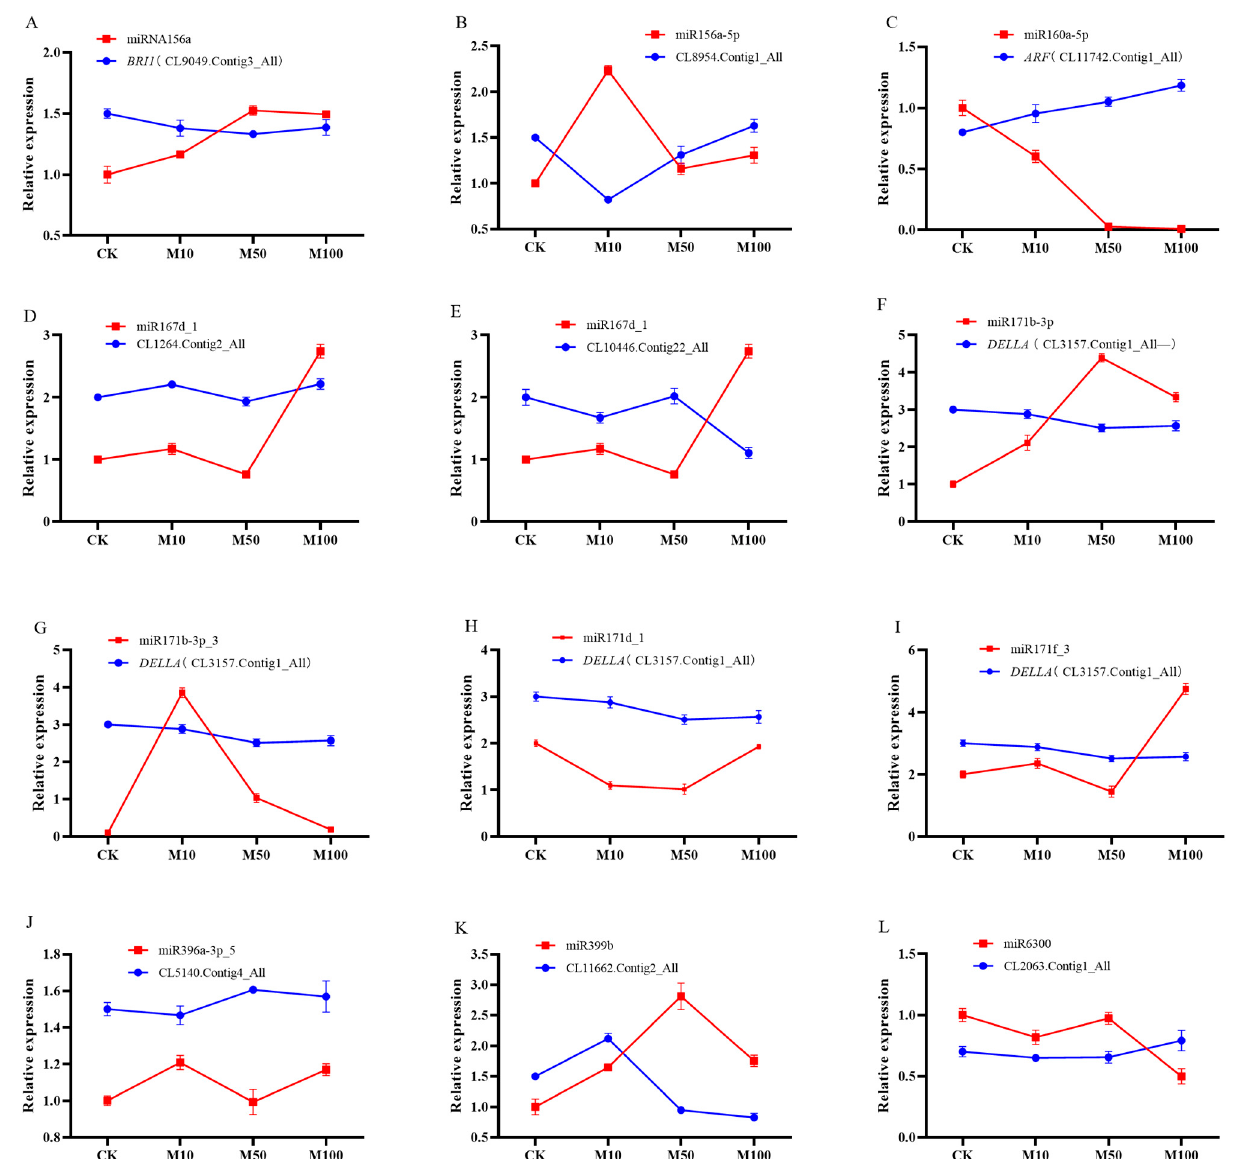
Figure 7. qRT-PCR verification of miRNAs and target genes in rosemary suspension cells under different concentrations of MeJA.